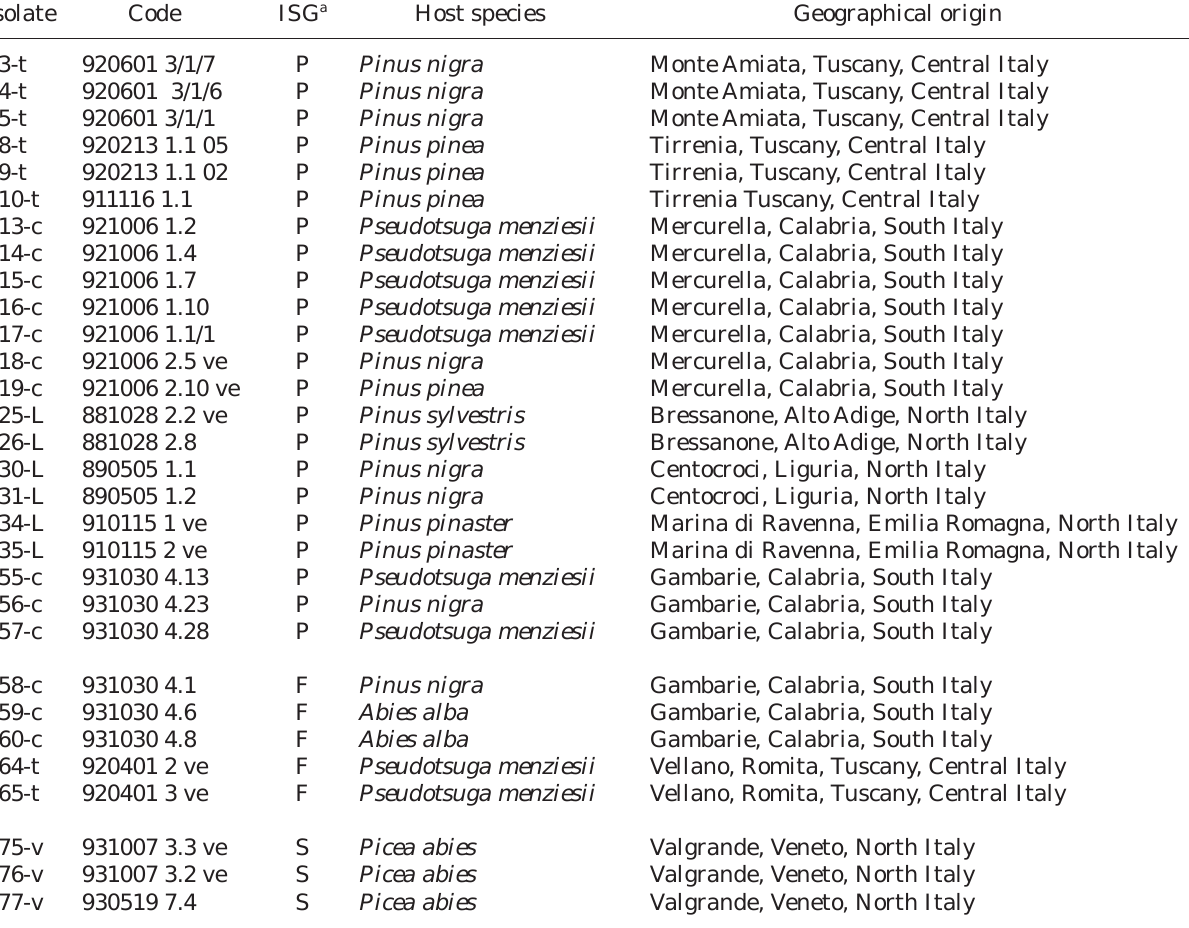
Table 1. List of isolates of Heterobasidion annosum used in the investigation grouped according their geographical